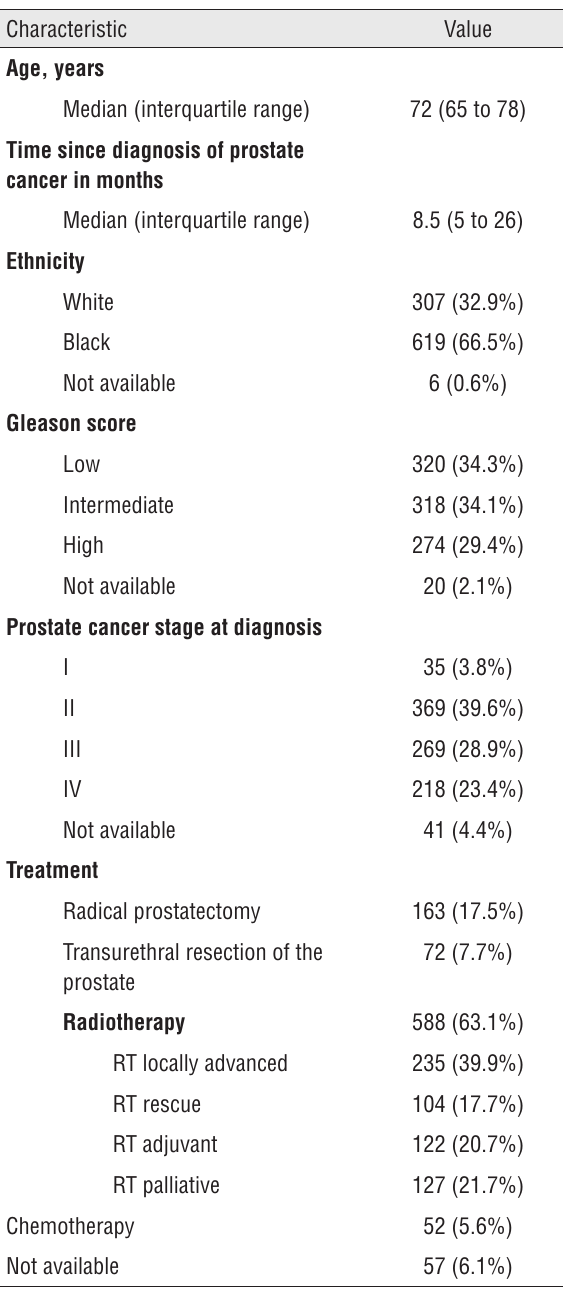
Table 1 - Patient characteristics